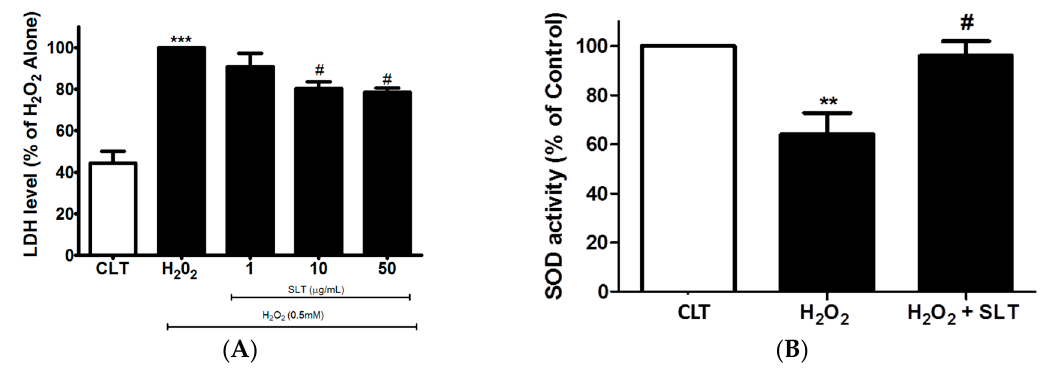
Figure 2. ( A ) Effects of SLT (1–50 µg/mL) on H 2 O 2 -induced lactate dehydrogenase (LDH) leakage in EA.hy926 cells ( n = 3). Data are presented as means ± S.D. *** p < 0.001 vs. control (CLT) group; # p < 0.05 vs. H 2 O 2 group; ( B ) Effects of SLT (50 µg/mL) on H 2 O 2 -inhibited superoxide dismutase (SOD) activity in EA.hy926 cells ( n = 3). Data are presented as means ± S.D. ** p < 0.01 vs. control (CLT) group; # p < 0.05 vs. H 2 O 2 group.